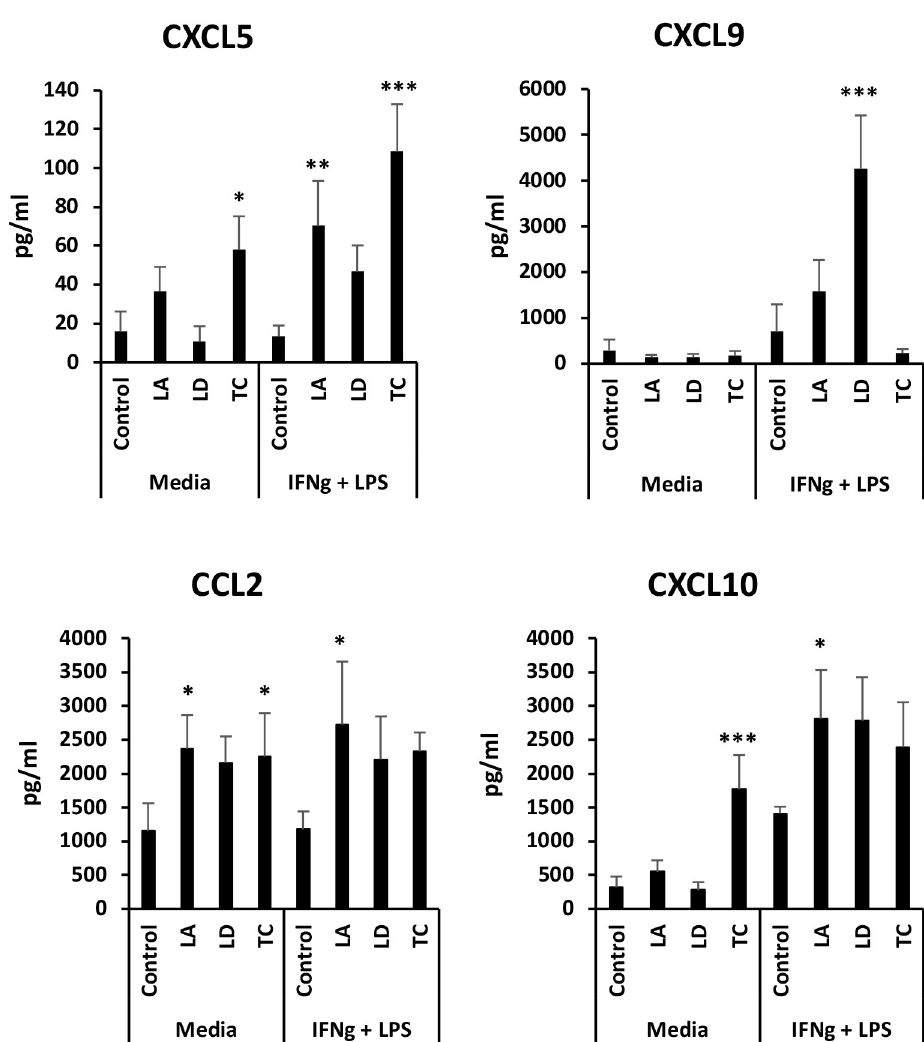
Fig 4. Infection of macrophages with L . amazonensis , L . donovani or T . cruzi induces secretion of specific chemokines by resting macrophages. Culture media of macrophages infected with L . amazonensis (LA), L . donovani (LD) or T . cruzi (TC) for 18 h and treated with IFN- γ +LPS or not 6 h before was used for chemokine determinations. Average and standard deviation of triplicates from one experiment is shown. � p < 0.05, �� p < 0.01 and ��� p < 0.001 by one-way ANOVA compared with control or IFN- γ +LPS control. One representative experiment out of 2 is shown.